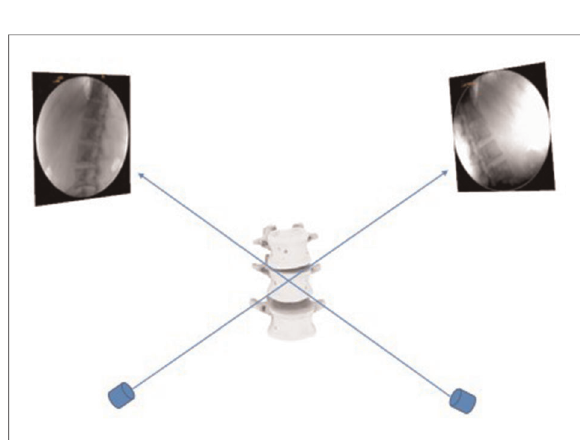
FIGURE 3 Virtual reproduction of the dual fl uoroscopic system and the vertebral